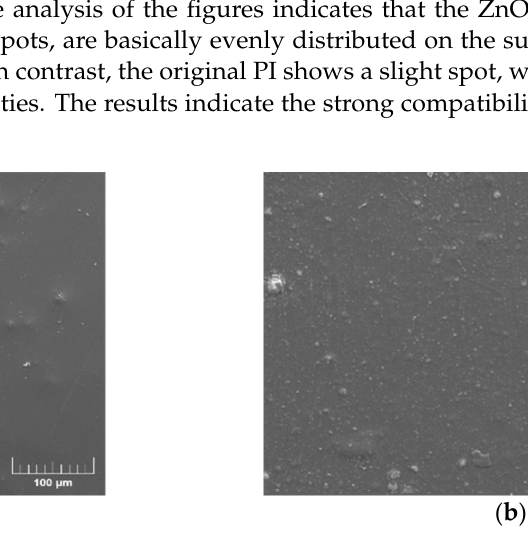
Figure 4. Representative SEM image of PI films. ( a ) Surface of the original PI film; ( b ) surface of the 2 wt.% ZnO/PI composite film.